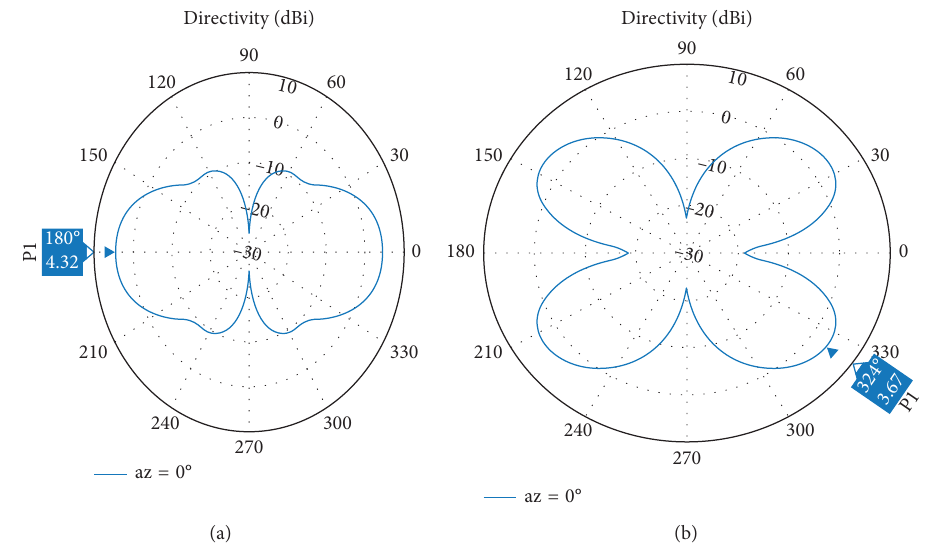
Figure 4: Dipole’s 360 degrees directivity (more precisely, for dipole at 460MHz left and right at 770MHz).